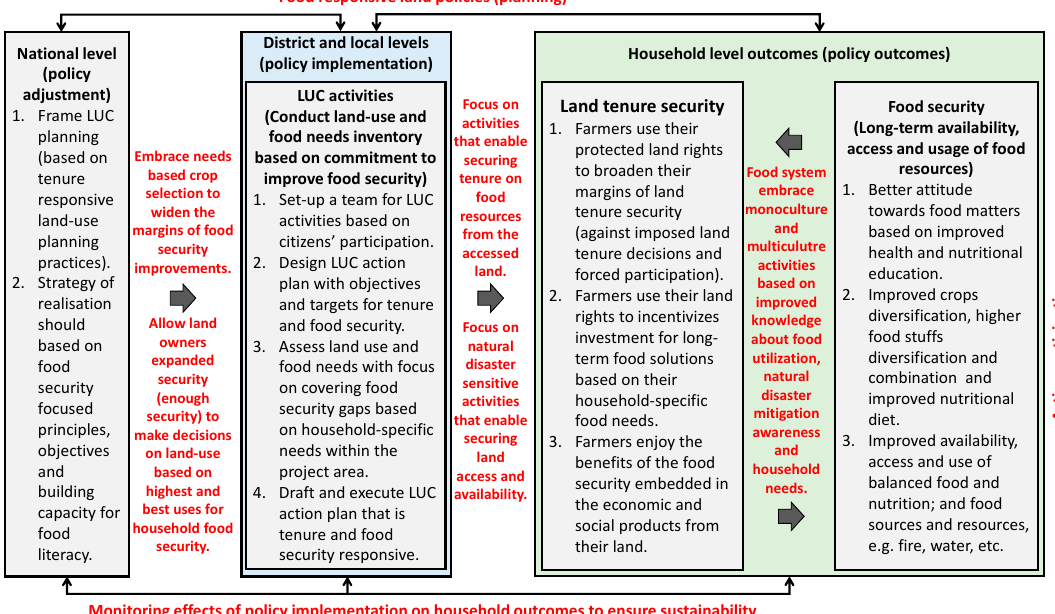
Figure 10. The operational framework for ensuring food security responsive LUC (based on tenure responsive land-use planning).